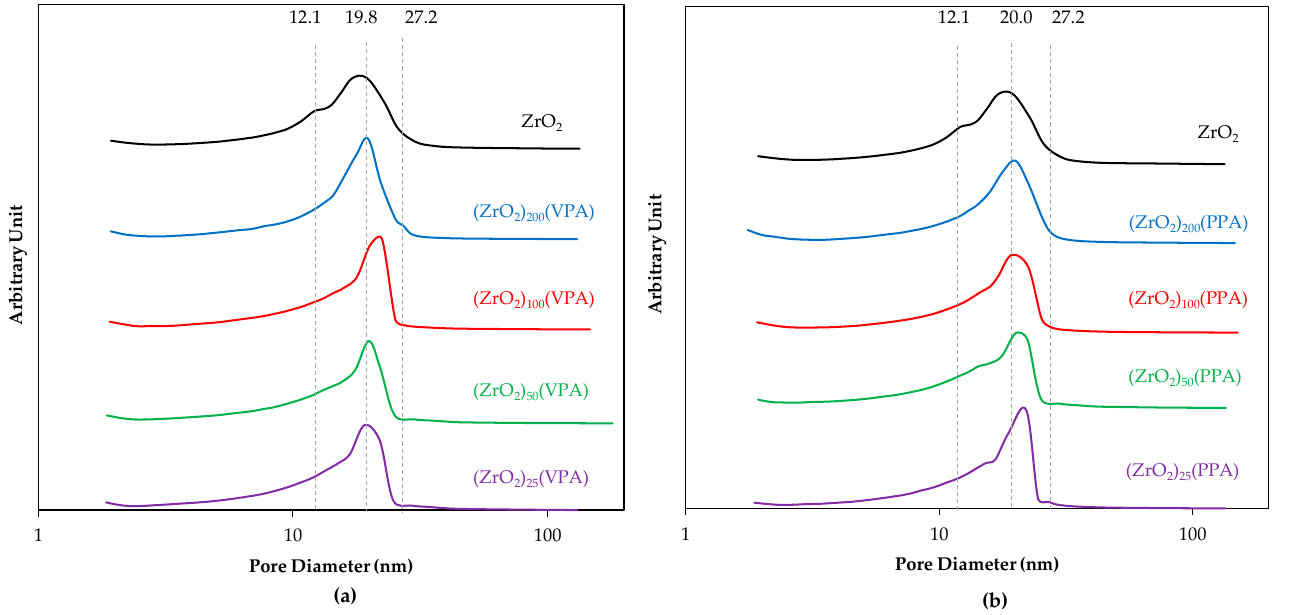
Figure 1. BJH pore size distributions for ( a ) (ZrO 2 ) x (vinylic (VPA)) and ( b ) (ZrO 2 ) x (phenylic (PPA)) samples (Zr/P ratio ( x ) = 25, 50, 100, 200) and bare ZrO 2 .